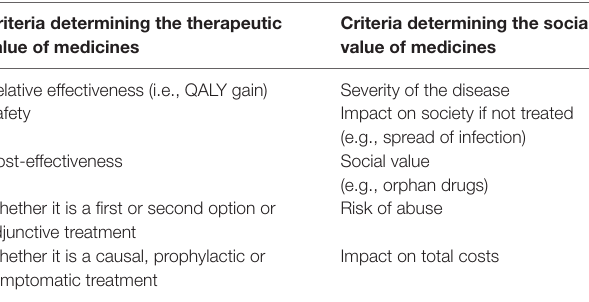
TABLE 1 | Criteria determining the therapeutic and social value of medicines (Szalay et al., 2011).